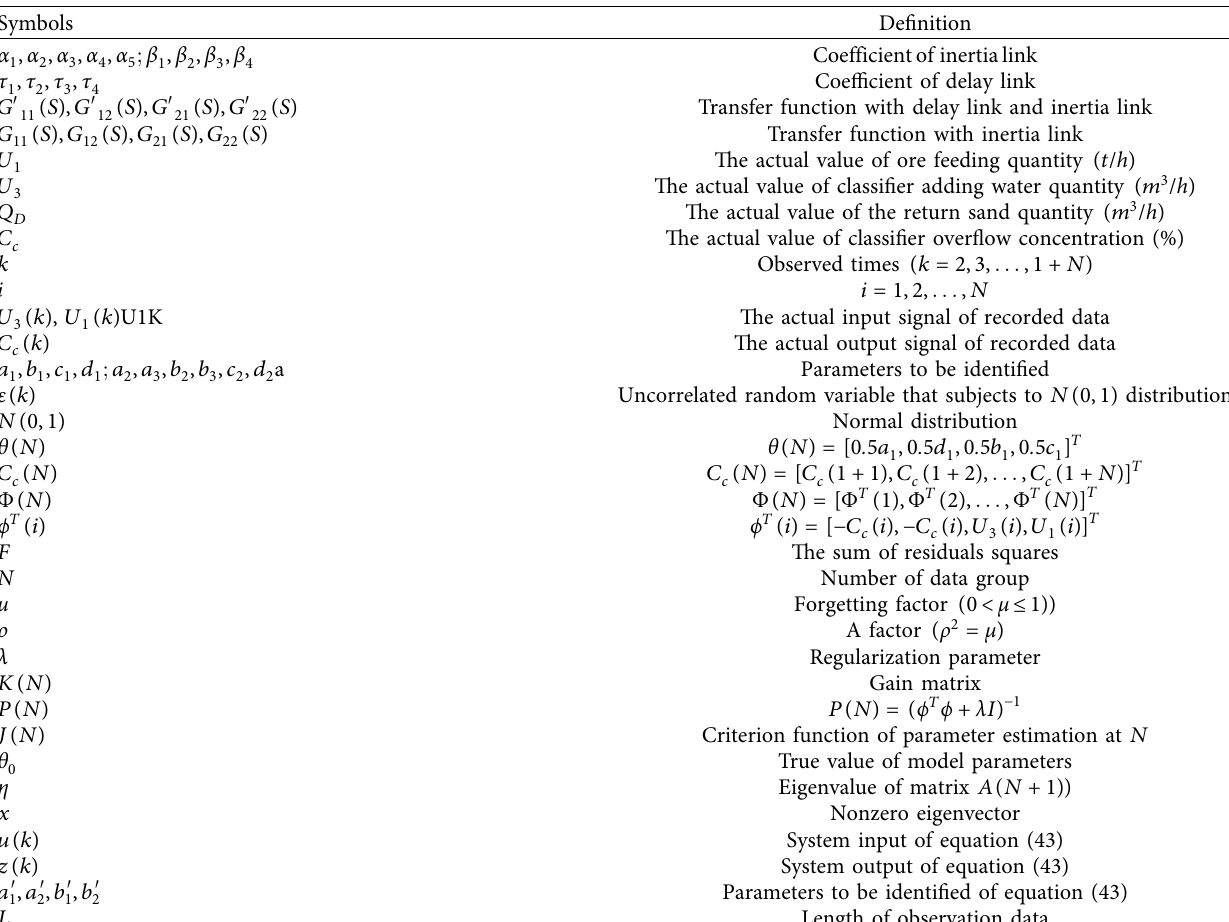
Table 7: A List of